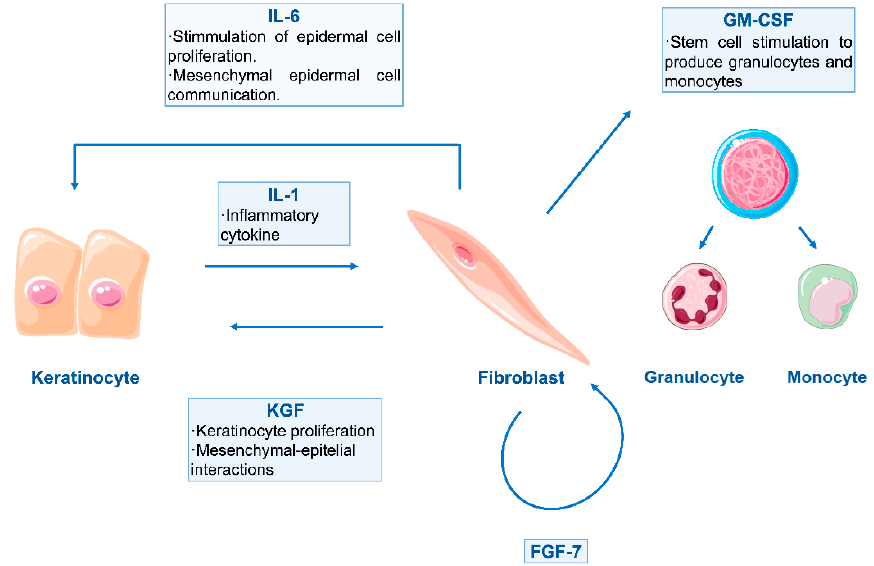
Figure 3. Schematic representation of double paracrine action between keratinocytes and fibroblasts. Keratinocyte-produced Interleukin-1 (IL-1) has an important role in this paracrine loop, as it targets fibroblasts and enhances the production of both fibroblast and keratinocyte growth factors (FGF–KGF). The production of Interleukin 6 (IL-6) is also initiated, and further stimulation of epidermal cells is given. Moreover, fibroblasts also release Granulocyte Macrophage Colony-Stimulating Factor (GM-CSF), in order to stimulate other cells for control and regulation of the wound healing process [116,118].